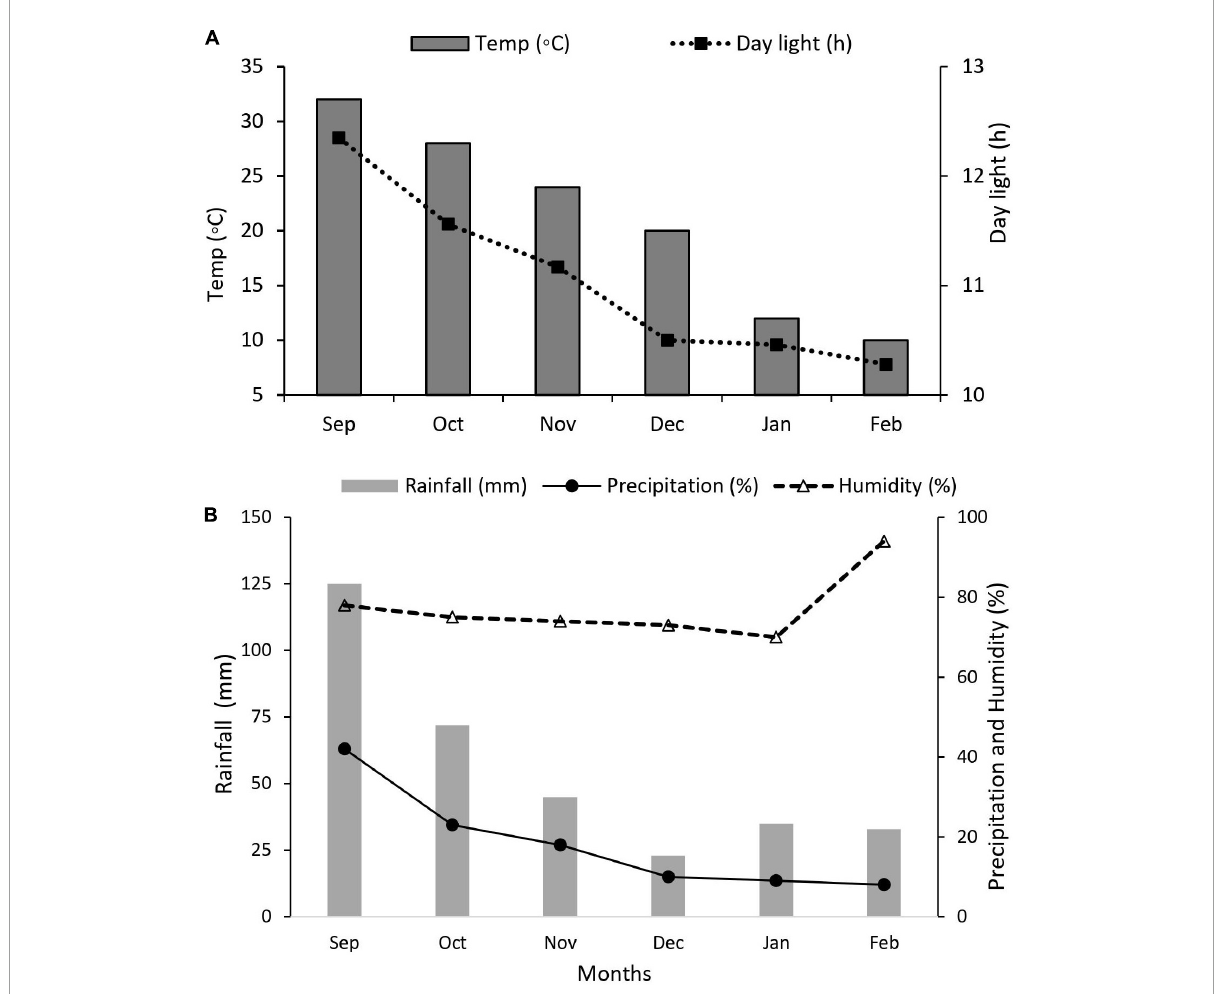
FIGURE2 Weather forecast report during the experiment. (A) Temperature ( ◦ C) and daylight (h), (B) rainfall (mm), precipitation (%), and humidity